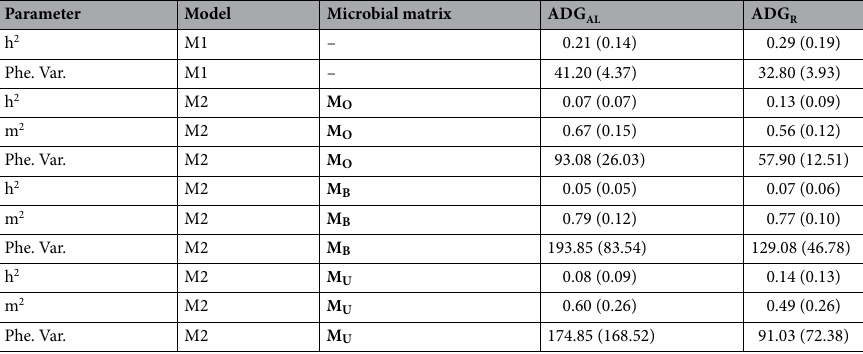
Table 1. Means (SD) of marginal posterior distributions of the heritability (h 2 ), microbiability (m 2 ) and phenotypic variance (Phe. Var.) for ADG AL and ADG R obtained with the mDataset. ADG AL , average daily gain in rabbits fed ad libitum; ADG R , average daily gain in rabbits fed under restriction; SD, standard deviation; M1, model without microbial effects; M2, model fitting the microbial effects; M O , microbial relationship covariance matrix defined from CSS normalized OTU counts, M B , microbial relationship covariance matrix defined from Bray–Curtis distance matrix; M U , microbial relationship covariance matrix defined from weighted Unifrac distance